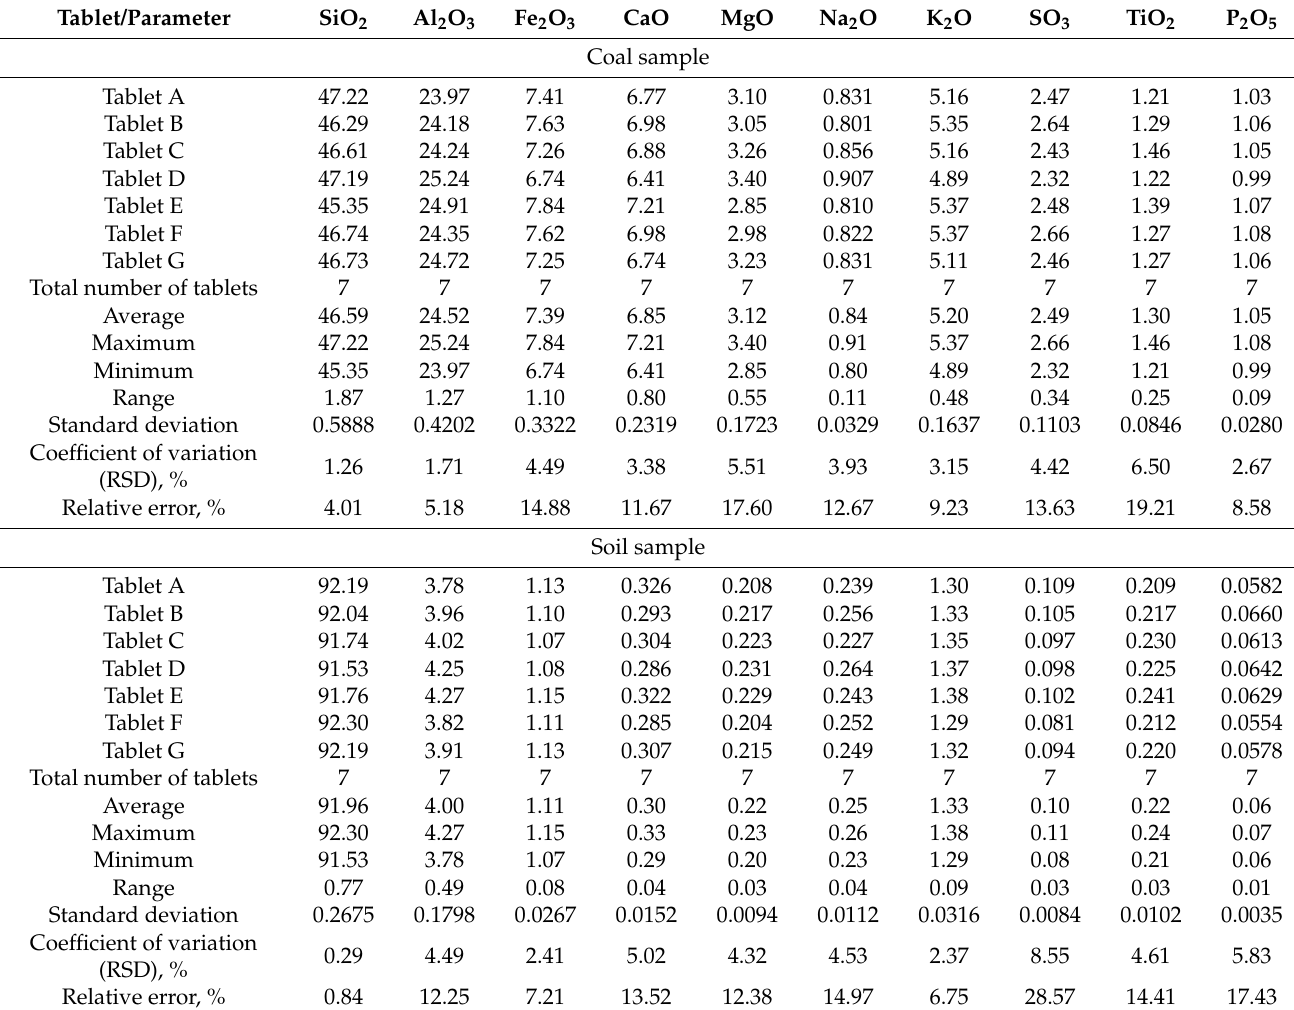
Table 6. The effect of the binding agent on the results of the analysis performed with the use of the SQX semi-quantitative